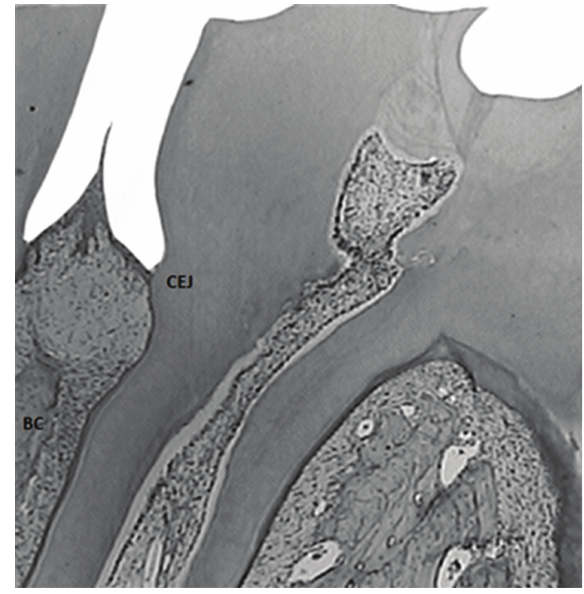
Figure 1: Distance between the CEJ in the mesial side of the second molar and the most apical portion of the junctional epithelium (CRJ-JE) and the distance between the CEJ and the alveolar bone crest (CEJ-BC). 4x magnificence. Image captured from the alcohol associated with stress group (GASL).